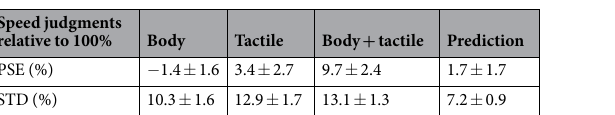
Table 2. PSEs and STDs of the ratio of visual speed to body, tactile, or combined motion needed for them to be judged as equal. Values are the averages of the fits to each individual participant’s data with standard